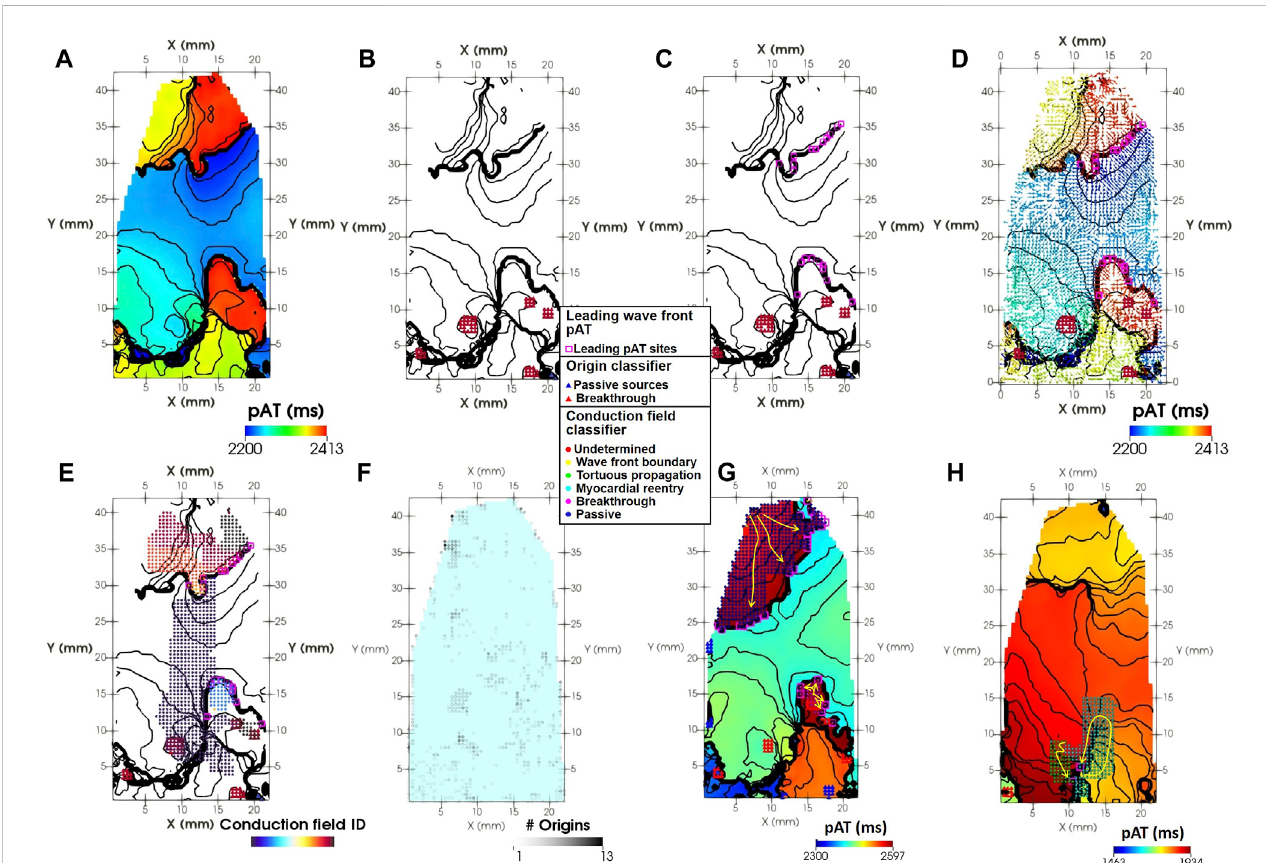
FIGURE 5 Spatial classi fi cation of activation sources. (A) A dynamic pAT map (left panel). (B) Origins of activation for breakthrough (red triangles) and passive (blue triangles)sources. (C) LeadingpATpointsoftheactivewavefront(pinksquares). (D) Conductionvectorsorientedinthedirectionoflocalpropagationoverlaid on (C) . (E) The conduction fi elds of leading pAT points. (F) Number ofaccumulated breakthrough or passive origins throughout wave front #4. (G) A pAT map shows leading wave front pAT sites (purple squares) with conduction fi elds emanating from a single breakthrough (red triangles) and passively from outside of the imaged fi eld of view. (H) The leading wave front during tachyarrhythmia was also maintained by reentrant propagation through myocardial pathways or regions of tortuous propagation. Yellow arrows indicate the local direction of